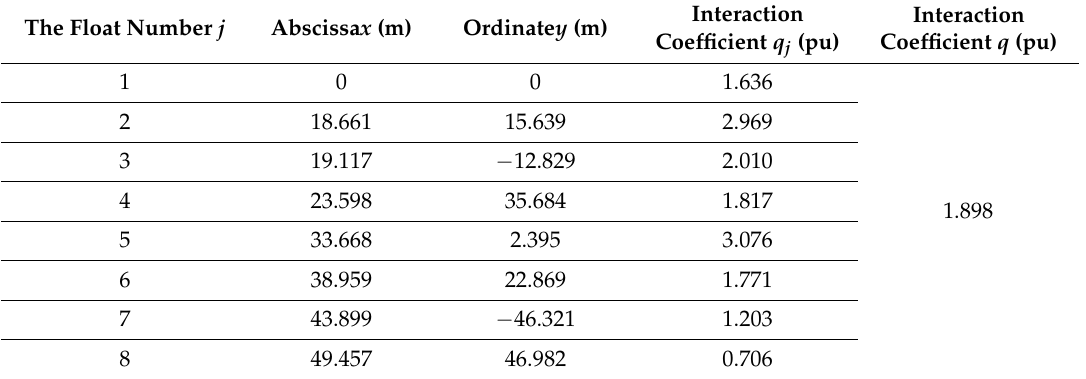
Table 4. The situation of each float when N = 8.